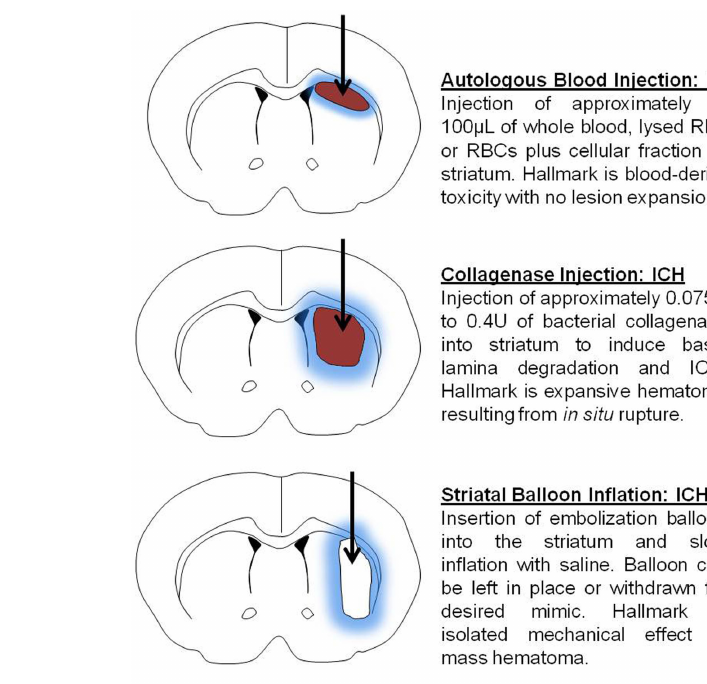
rupture of cerebral arterial vasculature. Striatal balloon inflation is utilized to assess the mass hematoma effect on cellular injury and to evaluate the consequences of hematoma removal. Models of SAH produce blood accumulation in the subarachnoid space either by injection into the cistern magna or perforation of the anterior cerebral artery. Arrows represent injection route and demarcate the mass hematoma